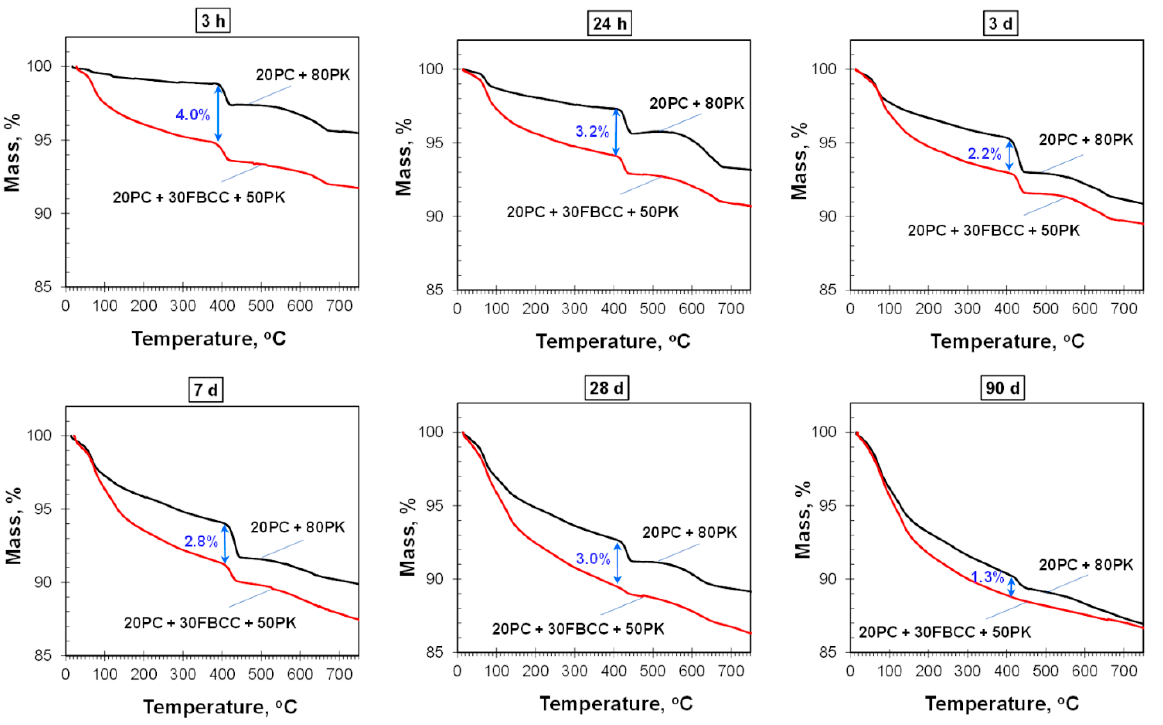
Figure 9. Comparison of TG curves obtained after different hydration periods for the reference sample (20PC + 80PK) and the paste containing the highest amount of FBCC (20PC + 30FBCC + 50PK), the differences between the amount of water bound in hydrates in both samples were indicated.